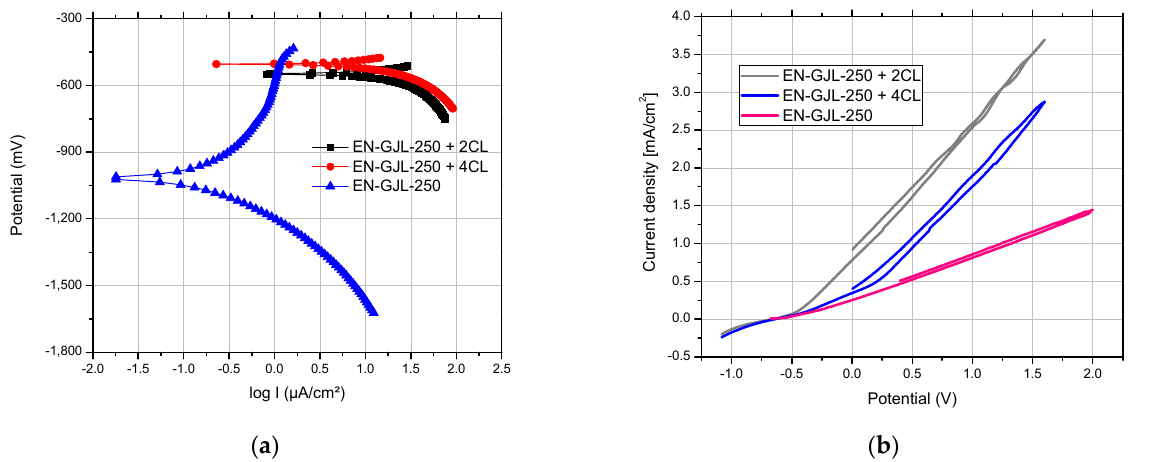
Figure 10. The chemical elements distribution for Al, O, F and C in the contact zone at the wear test: ( a ) distribution of all elements; ( b ) distribution of aluminium; ( c ) distribution of oxygen; ( d ) distribution of iron.